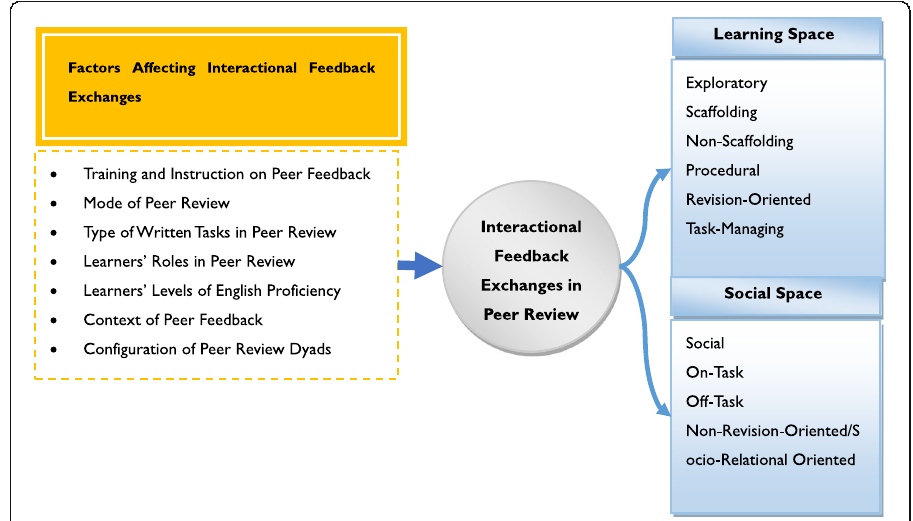
Fig. 2 A Dual Space-Interactional Feedback Model. This last figure reflects how we conceptualized the various categories of learners ’ interactional feedback exchanges as two spaces: learning/task space where learners focus on the task and social space where learners need to build up a friendly atmosphere for peer review. Both spaces are affected by several factors, including type of texts, mode of peer review,